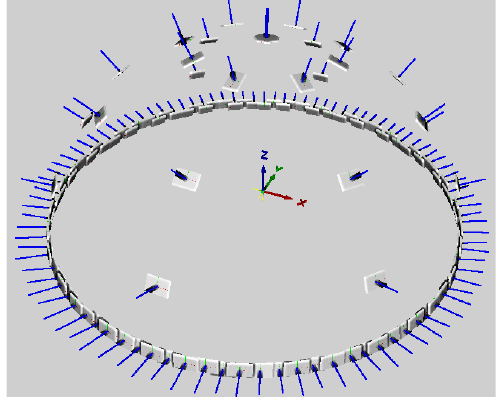
Figure 10: A typical camera network obtained rotating the object around the Z axis in order to have a better coverage.